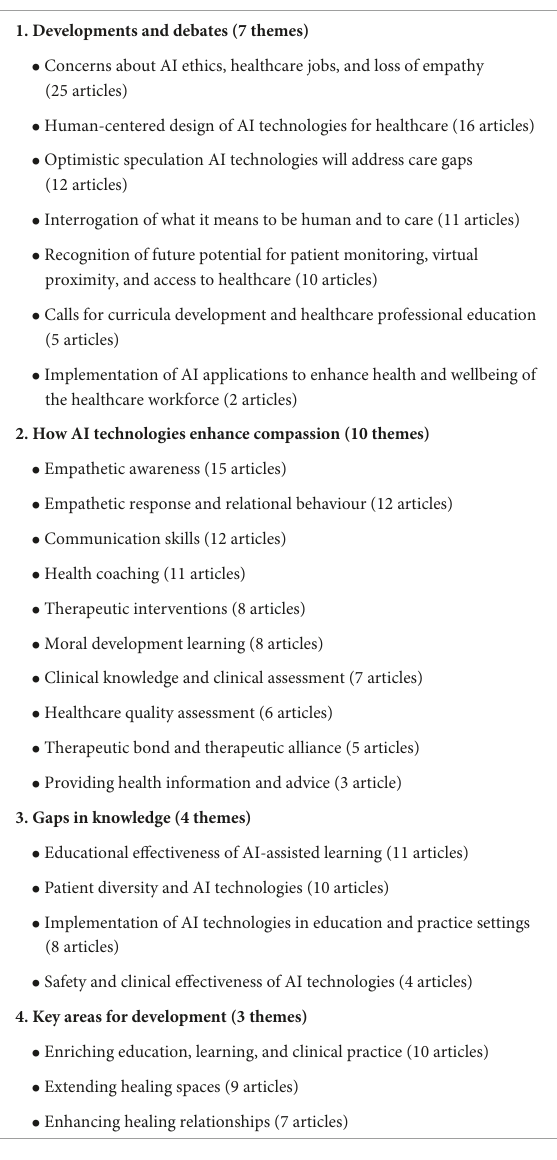
TABLE 3 Overview of themes in the